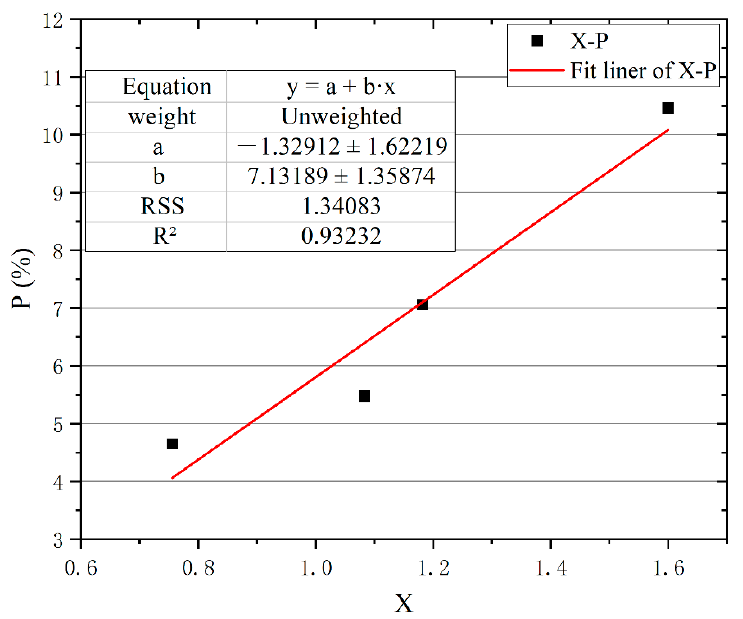
Figure 6. Regression analysis of microstructure parameters and pyrolysis water loss.